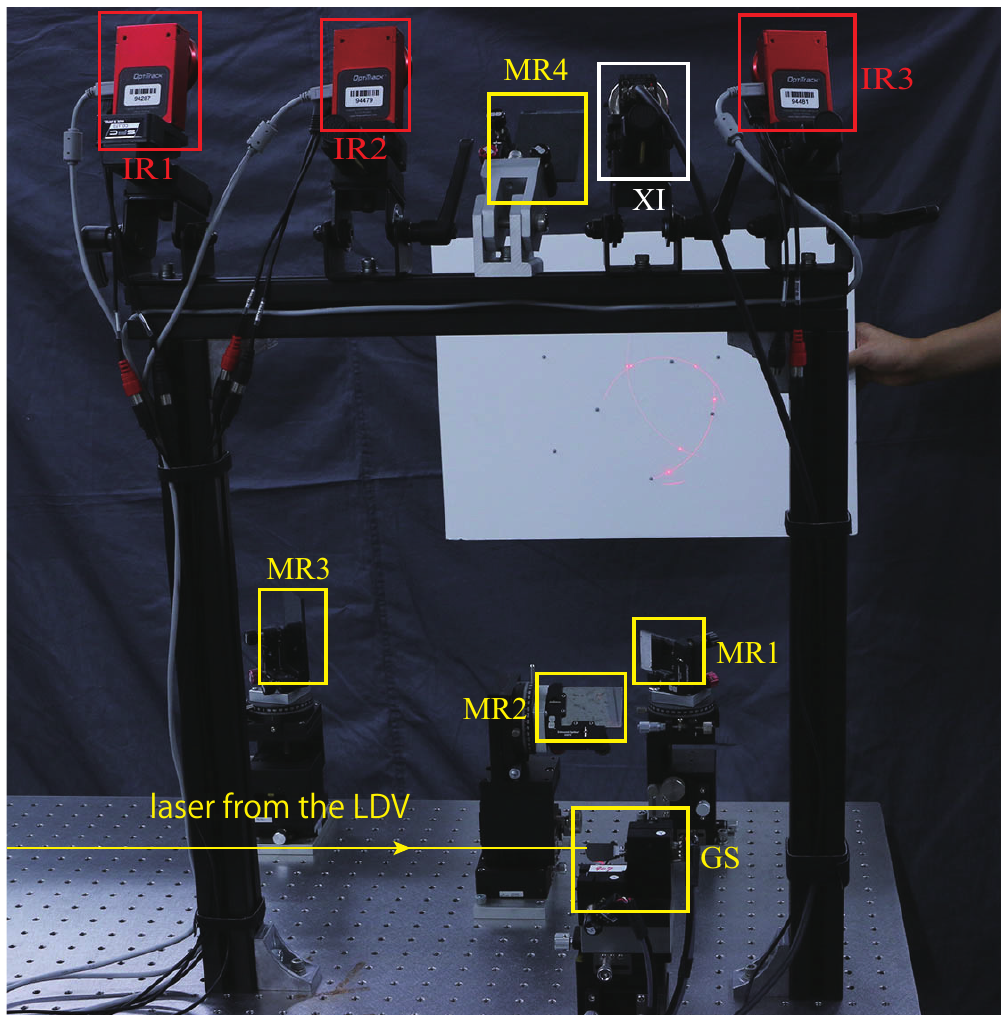
Figure 3. Experimental setup. Photograph of the system and the experimental condition. MR1~MR4 are the mirrors, and GS is the galvanometer scanner. IR1~IR3 are IR illumination sources and cameras. XI is a monochrome camera. Calibration object was moved manually 1 m away from the